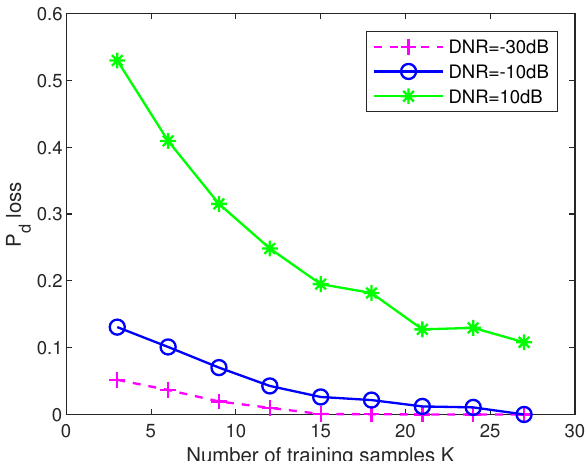
Figure 7. The P d loss of the proposed method (TNR = − 12 dB, P fa = 10 − 3